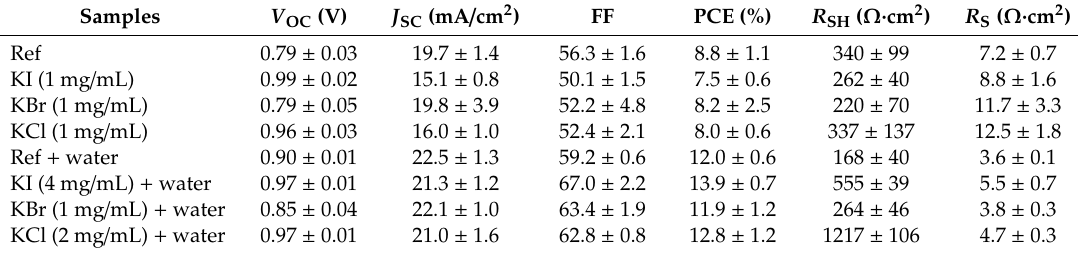
Table 1. The corresponding photovoltaic parameters of devices in Figure 1.